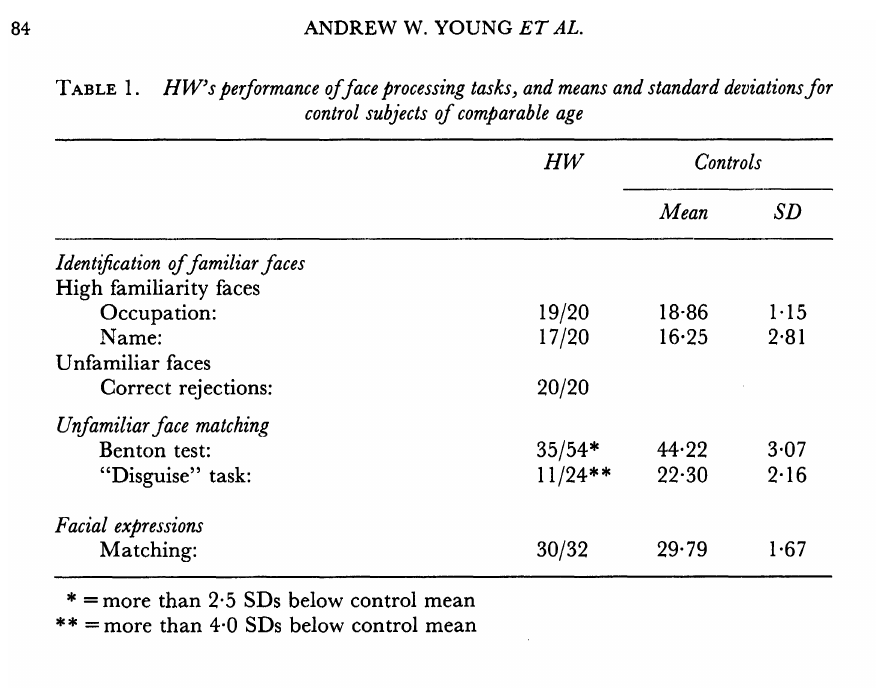
TABLE 1. HW's performance of face processing tasks, and means and standard deviations